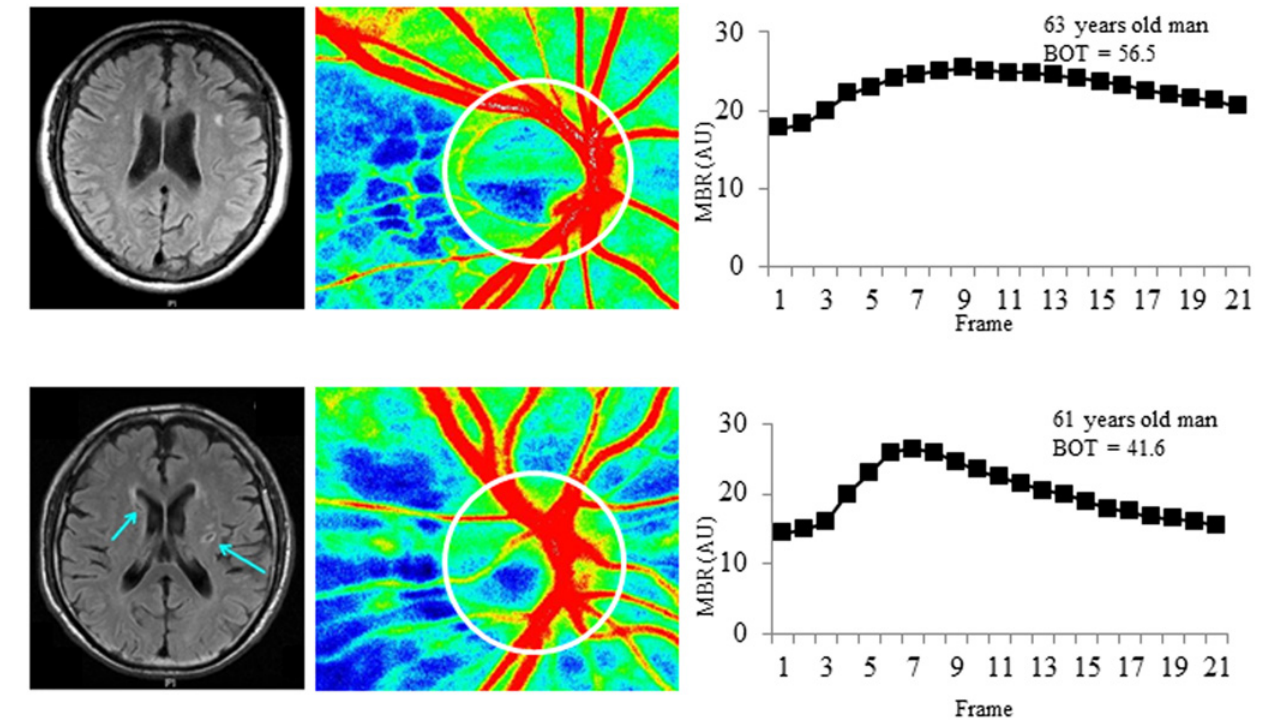
Fig 2. Representative cases with and without silent brain infarction. Above: 63-year-old man without silent brain infarction (SBI). Below: 61-year-old man with SBI. Left: magnetic resonance images; middle: laser speckle flowgraphy (LSFG) color maps; right: LSFG-measured mean blur rate (MBR) waveform. The arrows in the MRI images for the SBI case show regions of clearly visible SBI. The ellipse indicates the optic nerve head (ONH) margin. The LSFG software automatically divided the overall ONH into large vessel and capillary areas. The MBR waveform for the SBI case show that the peak of the waveform is steeper and has a more clearly defined peak than the non-SBI case, which may reflect the effect of age-related vascular changes on the MBR waveform. Furthermore, the values for BOT are 56.5 and 41.6 arbitrary units in the SBI and non-SBI cases, respectively.